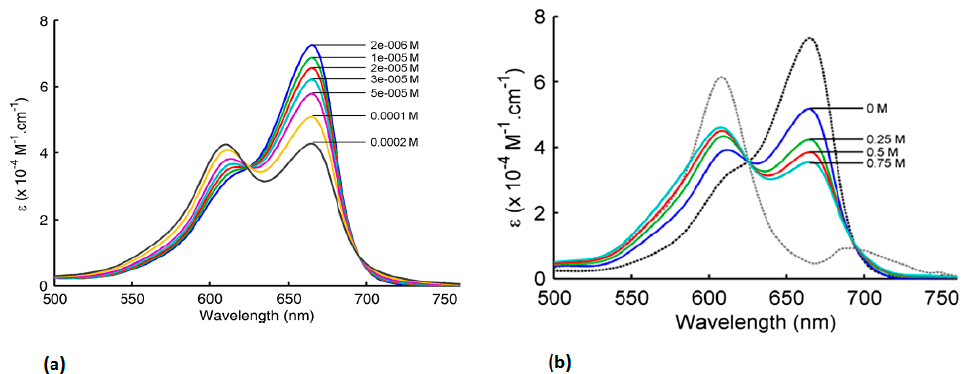
Figure 2. ( a ) Absorbance spectra of different concentrations of methylene blue in water ( b ) Absorbance spectra of 80 μ M solution of methylene blue in water with 4 different salt concentrations (grey dotted line is absorbance of dimer in water, black dotted line is absorbance of monomer in water) Figure from [54] reproduced with permission from the publisher.